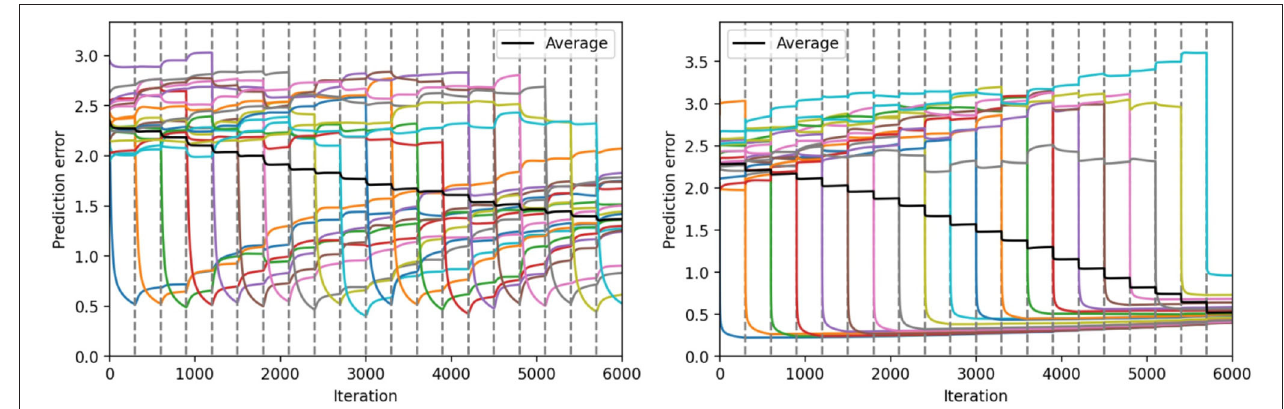
FIGURE 6 | Continual learning results with the ESN model (left) and the Conceptors model (right). We represent the average prediction error over 10 seeds, for the continual learning of 20 sequential patterns, obtained on the first test set. The colored lines correspond to the prediction error on each individual task, and the black line corresponds to the prediction error averaged on all tasks. The 20 tasks are delimited by the dashed gray lines.